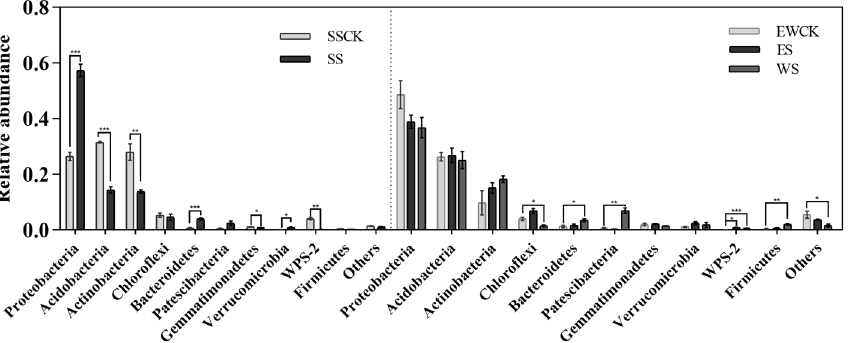
Figure 8. Relative abundance of soil microorganisms at the phylum level under the intercropped maize ecological shading in tea plantation (Note: *, **, and *** show significantly different by the t test at p < 0.05, p < 0.01 or p < 0.001).